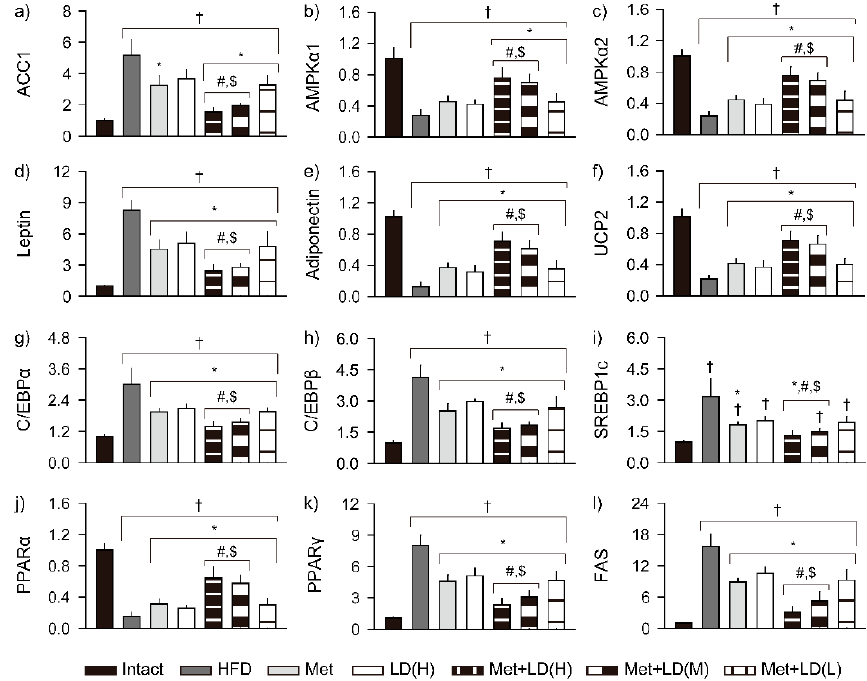
Figure 6. Combination effects on gene expression involved in metabolic alteration. ( a – c ) mRNA expressions of acetyl-CoA carboxylase 1 (ACC1), AMP-activated protein kinase (AMPK) α 1, and AMPK α 2 in the liver. ( d – l ) mRNA expressions of leptin, adiponectin, uncoupling protein (UCP)2, CCAAT-enhancer-binding protein (C/EBP) α , C/EBP β , sterol-regulatory-element-binding protein 1c (SREBP1c), peroxisome proliferator-activated receptor (PPAR) α , PPAR γ , and fatty acid synthase (FAS) in the periovarian fat tissues. Values are represented as the means ± SDs ( n = 8). †, *, #, and $: p < 0.05 vs. the Intact, HFD control (HFD), Met, and LD(H) groups, respectively.